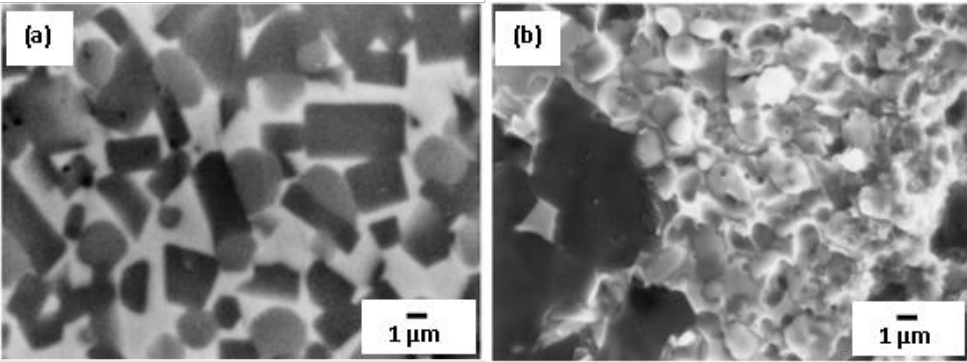
Figure 6. SEM micrograph of TiB 2 -TiC-Ni composite synthesized by pressure-assisted combustion of dense B 4 C-3Ti-1.5Ni powder blend (derived from the center of the specimen) ( a ) and fracture surface of the product obtained from the B 4 C-3Ti-1.5Ni blend diluted by 20 wt.% B 4 C ( b ). Reprinted from Gotman et al., 1998 with copyright permission, Copyright 1998 Materials Science and Engineering: A [63].